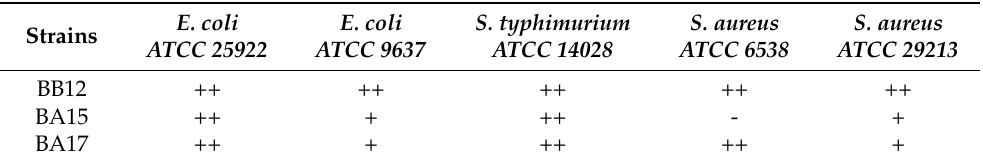
Table 5. Antimicrobial activity against pathogenic